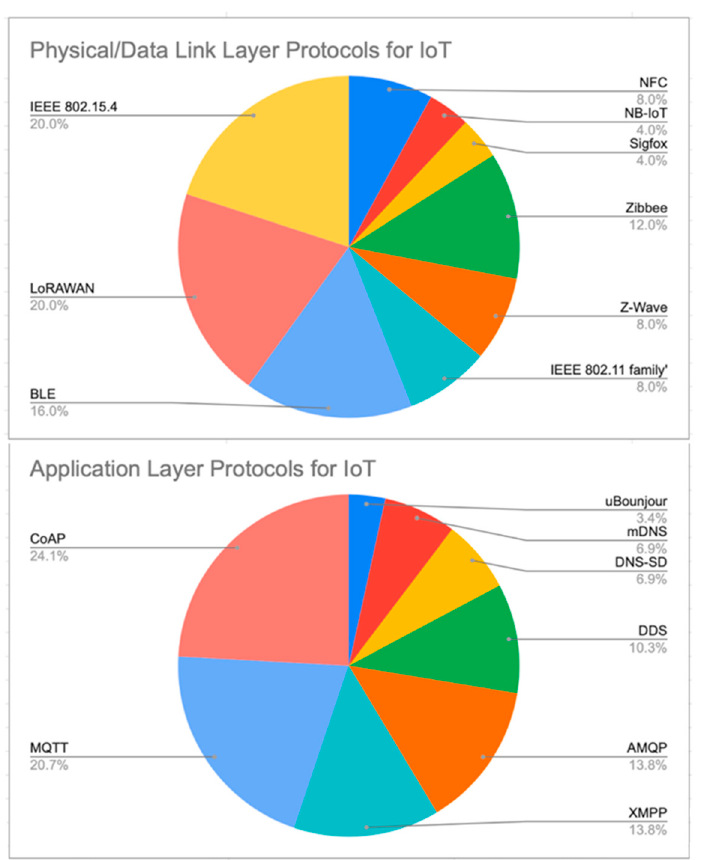
Figure 4. In the eight studies, the number of times each protocol is described is recorded.